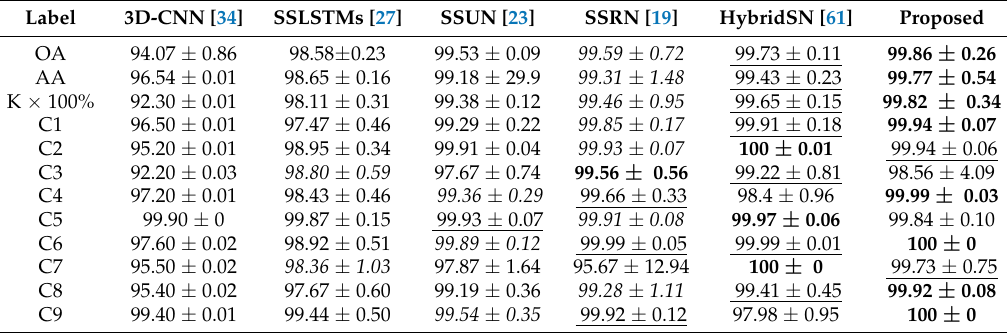
Table 7. Overall Accuracy, Average Accuracy, Kappa Value, and Class Wise Accuracy of our proposed method versus other methods on Pavia University (PU) dataset with 10% training samples. The best performance is in bold, the second-best performance is underlined, and the third-best is in